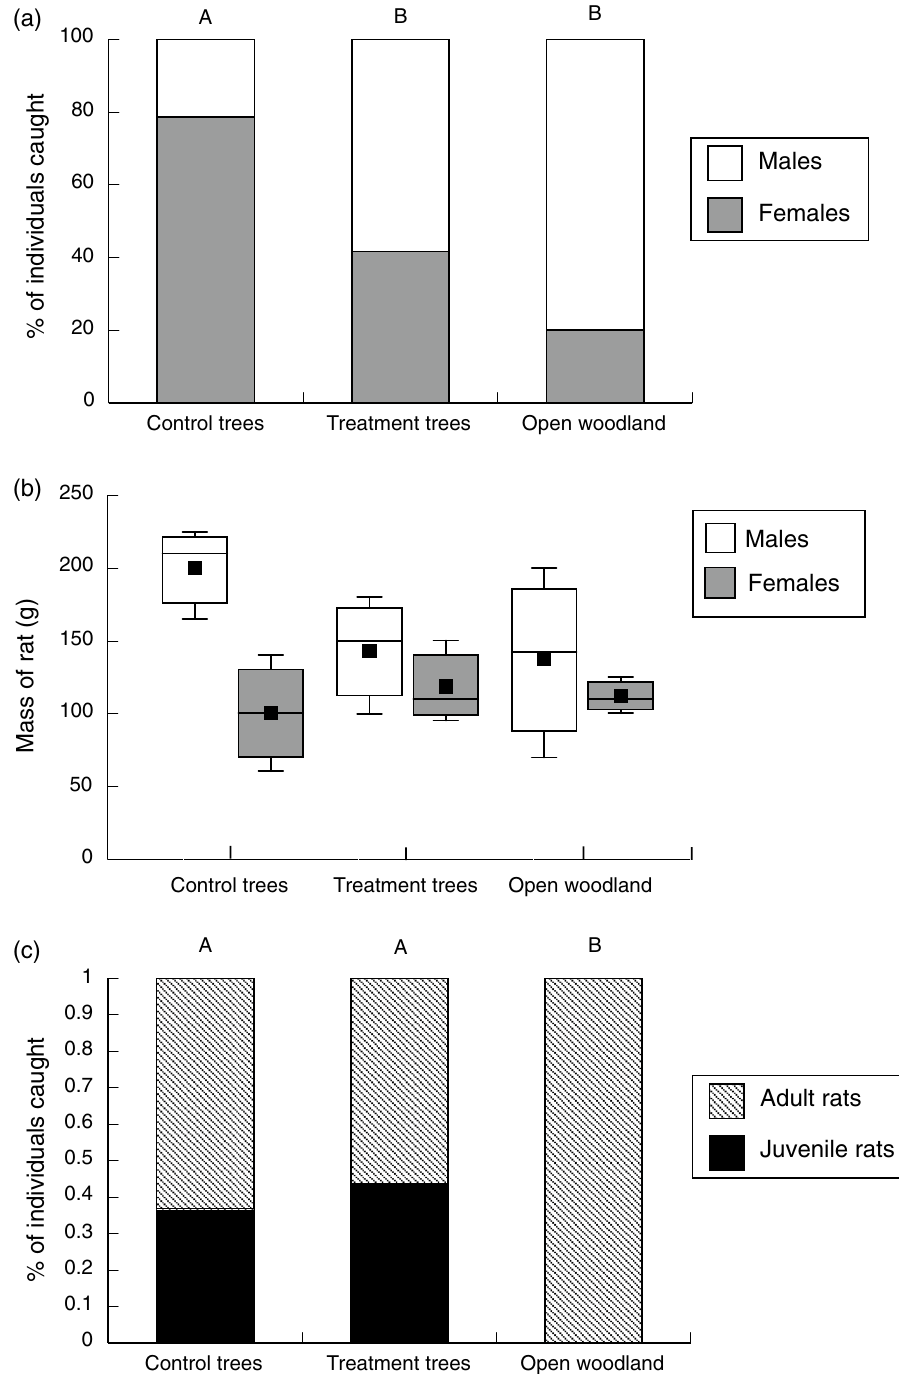
Figure 2. Effect of habitat on ecological traits of Pale Field Rats. Animals were trapped in ‘Open Woodland’ or under Chinee Apple Trees with intact foliage (‘Intact trees’) or with lower foliage removed (‘Trimmed trees’). Bars denoted by the same letter within each panel are not significantly different ( p < 0.05). ( a ) Sex ratios during the January breeding season. ( b ) Body mass of each sex during the January breeding season; box and whisker plots denote mean, median, minimum, maximum, and interquartile ranges. ( c ) Age structure (adults vs. juveniles) during the May nesting